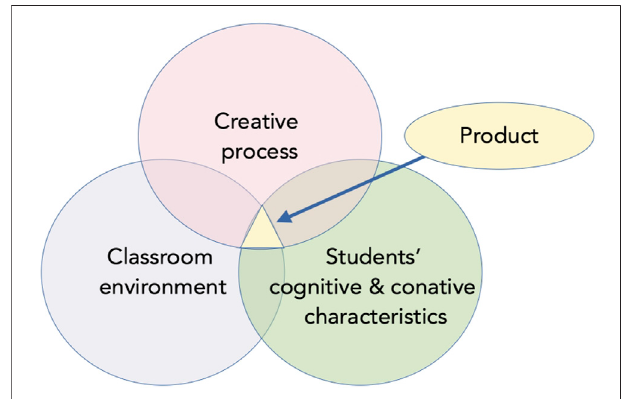
FIGURE1| Con fl uencemodelforeducationalrobotics.Note:This fi gure is adapted from Nemiro et al.